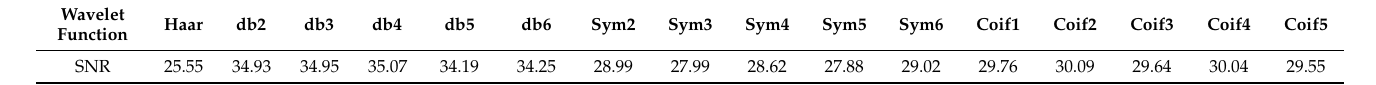
Figure 8. Passenger flow data in different states: ( a ) passenger flow data embarking on the train; ( b ) Passenger flow data disembarking from the train.